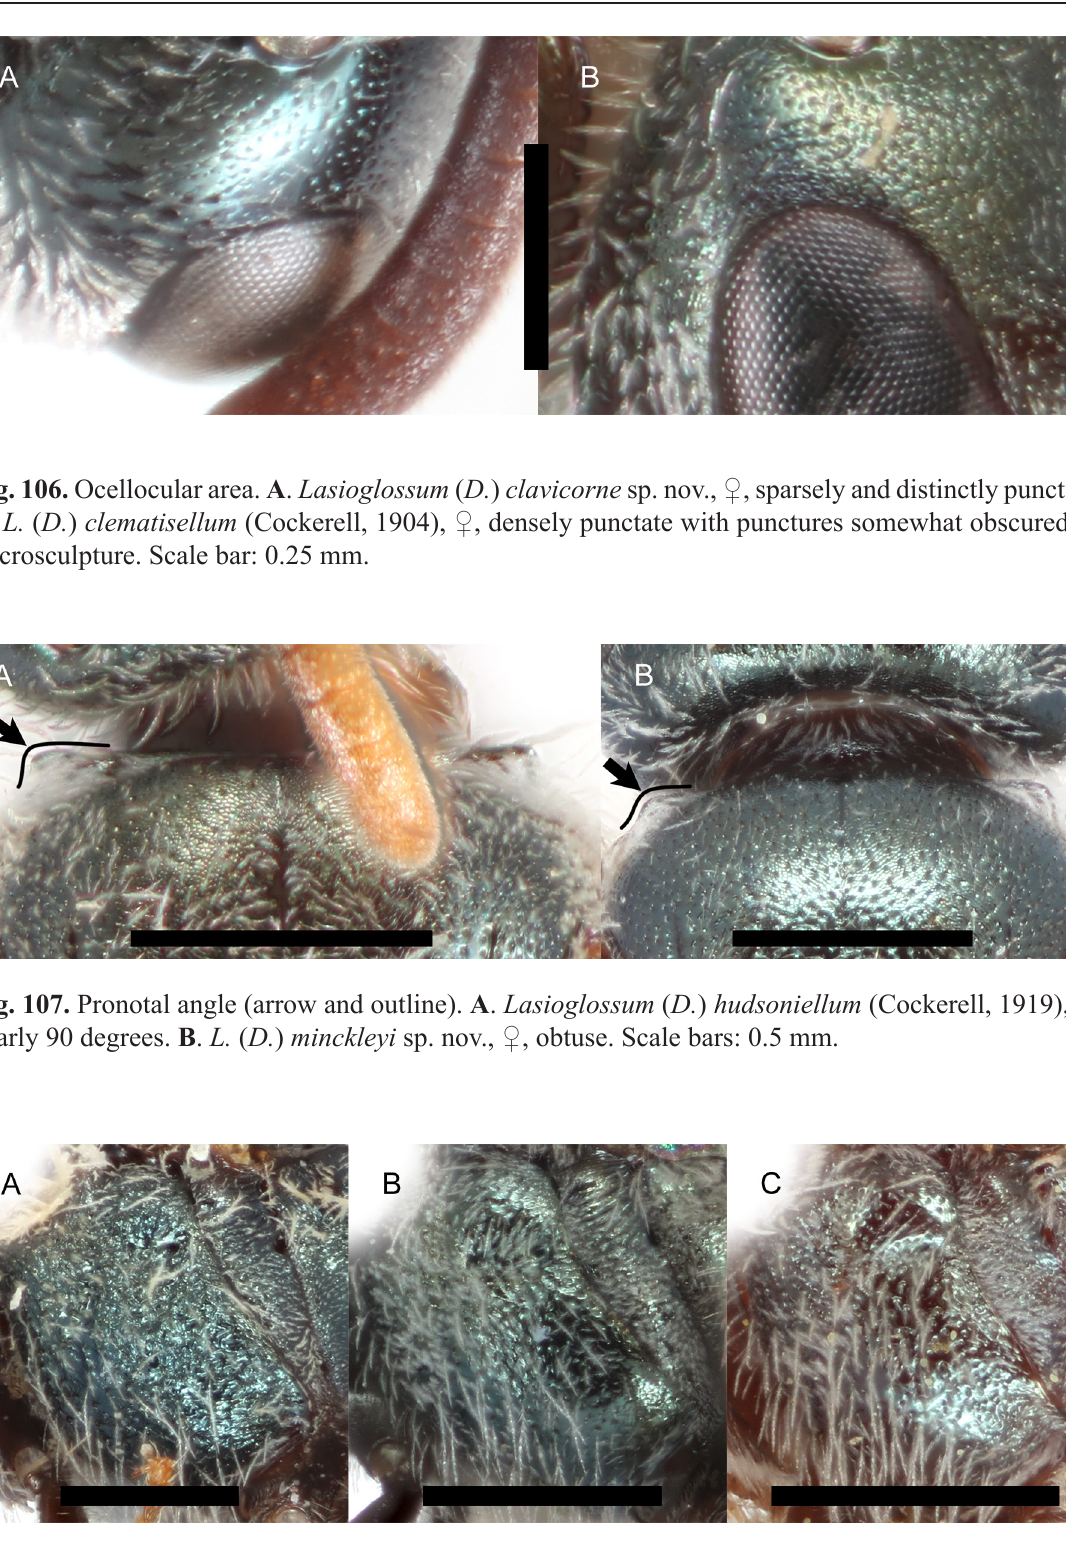
Fig. 108. Mesepisternum. A . Lasioglossum ( D. ) eophilus (Ellis, 1914), ♀, entirely rugose. B . L. ( D. ) mesillense (Cockerell, 1898), ♀, ruguloso-punctate in dorsal half, smooth and distinctly punctate in ventral half. C . L. ( D. ) imbriumbrae sp. nov., ♀, entirely smooth and distinctly punctate. Scale bars: 0.5